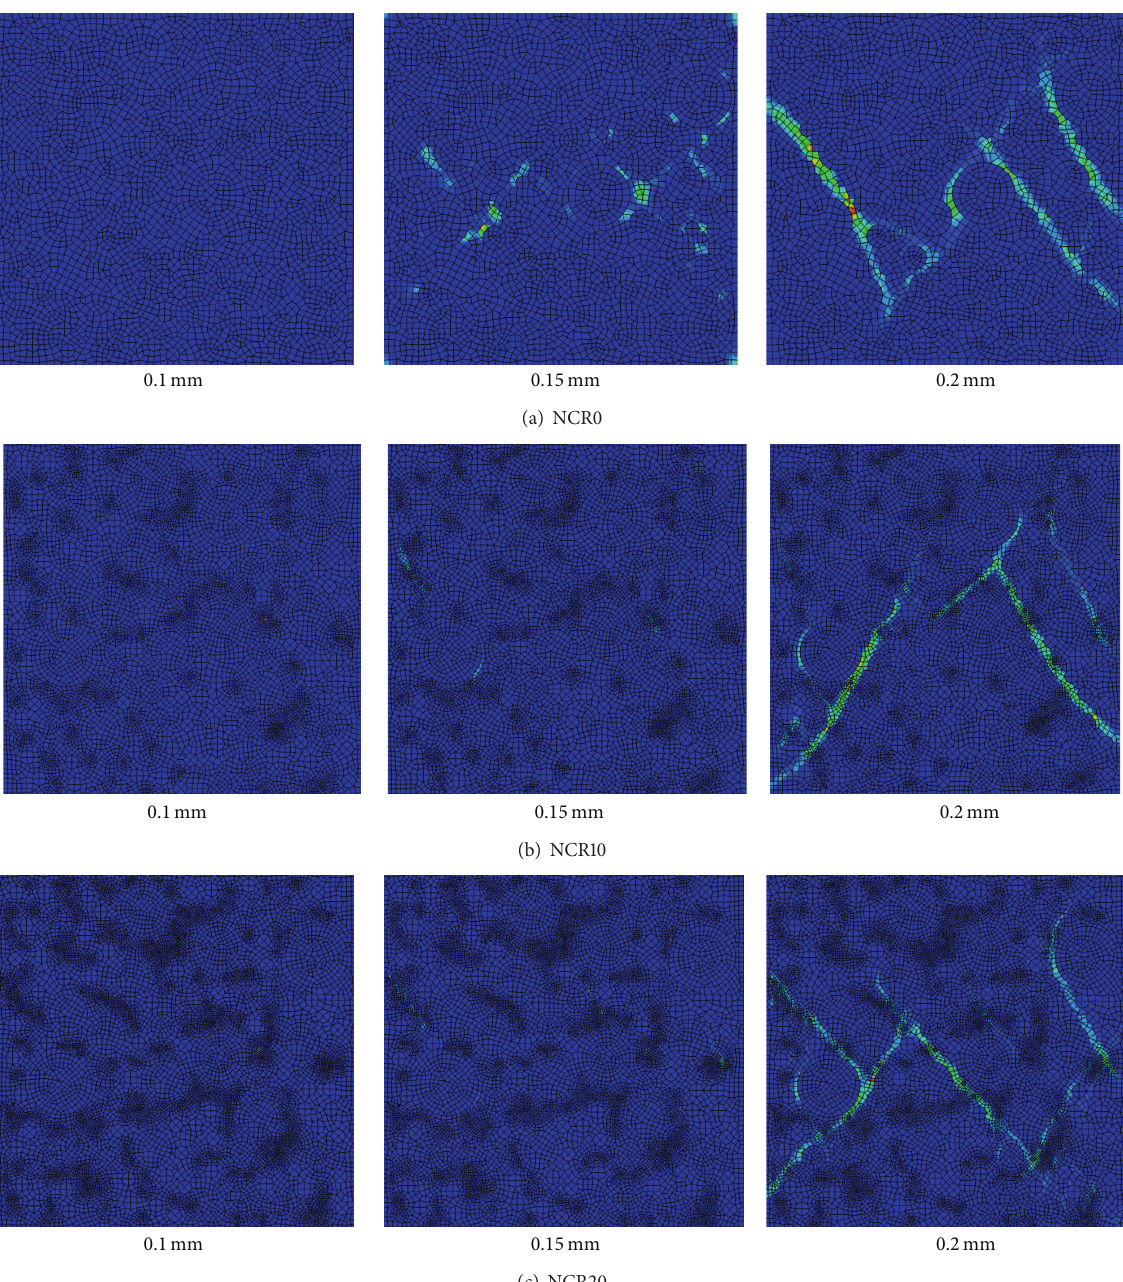
Figure 10: Fracture distribution in rubber concrete without taking into account the bonding interfaces.